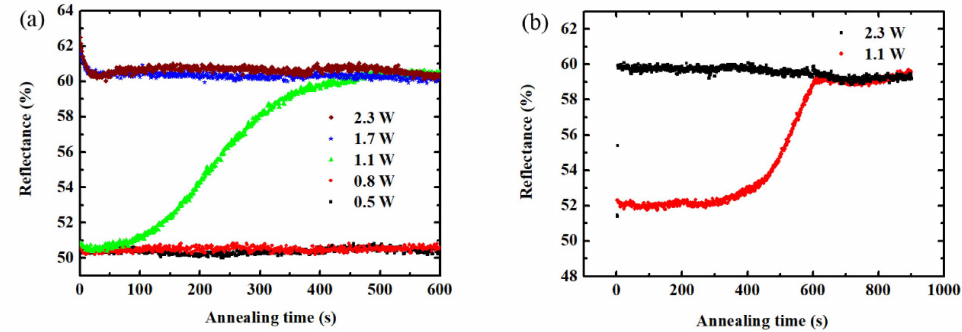
Figure 1. Reflectance as a function of the annealing time obtained in the case of the ( a ) TF1, ( b ) TF2 and TF3